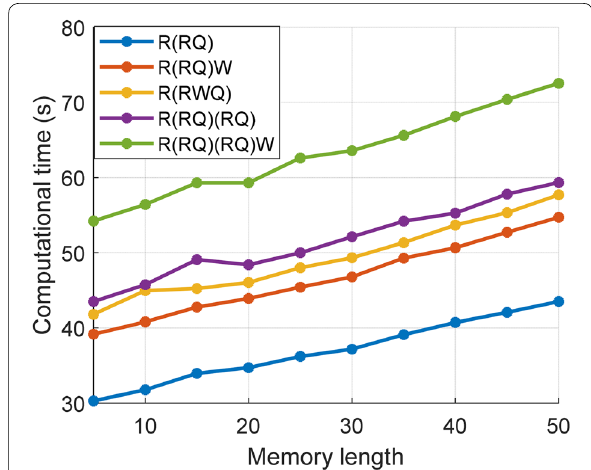
Figure 10 Overall computational times of SOC estimation under different memory lengths